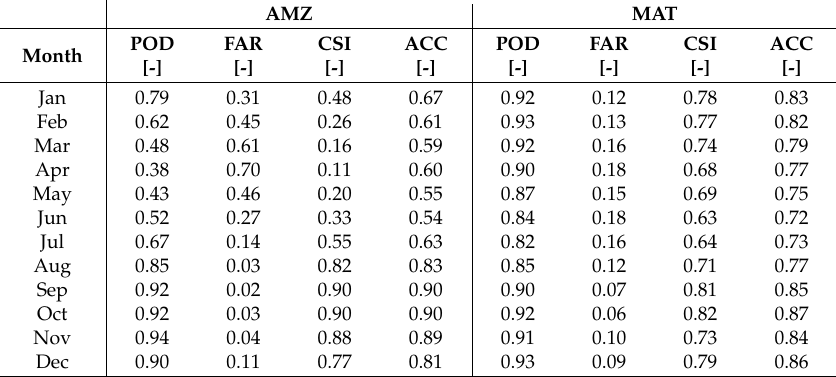
Table 7. Probability of detection (POD), false alarm ratio (FAR), critical success index (CSI), and accuracy (ACC) for the daily rainfall estimates derived from SM2RAIN-CCI against observations from the GBGR data over the main biomes of NEB during the period 1998 – 2015. For each score, the median value is reported.